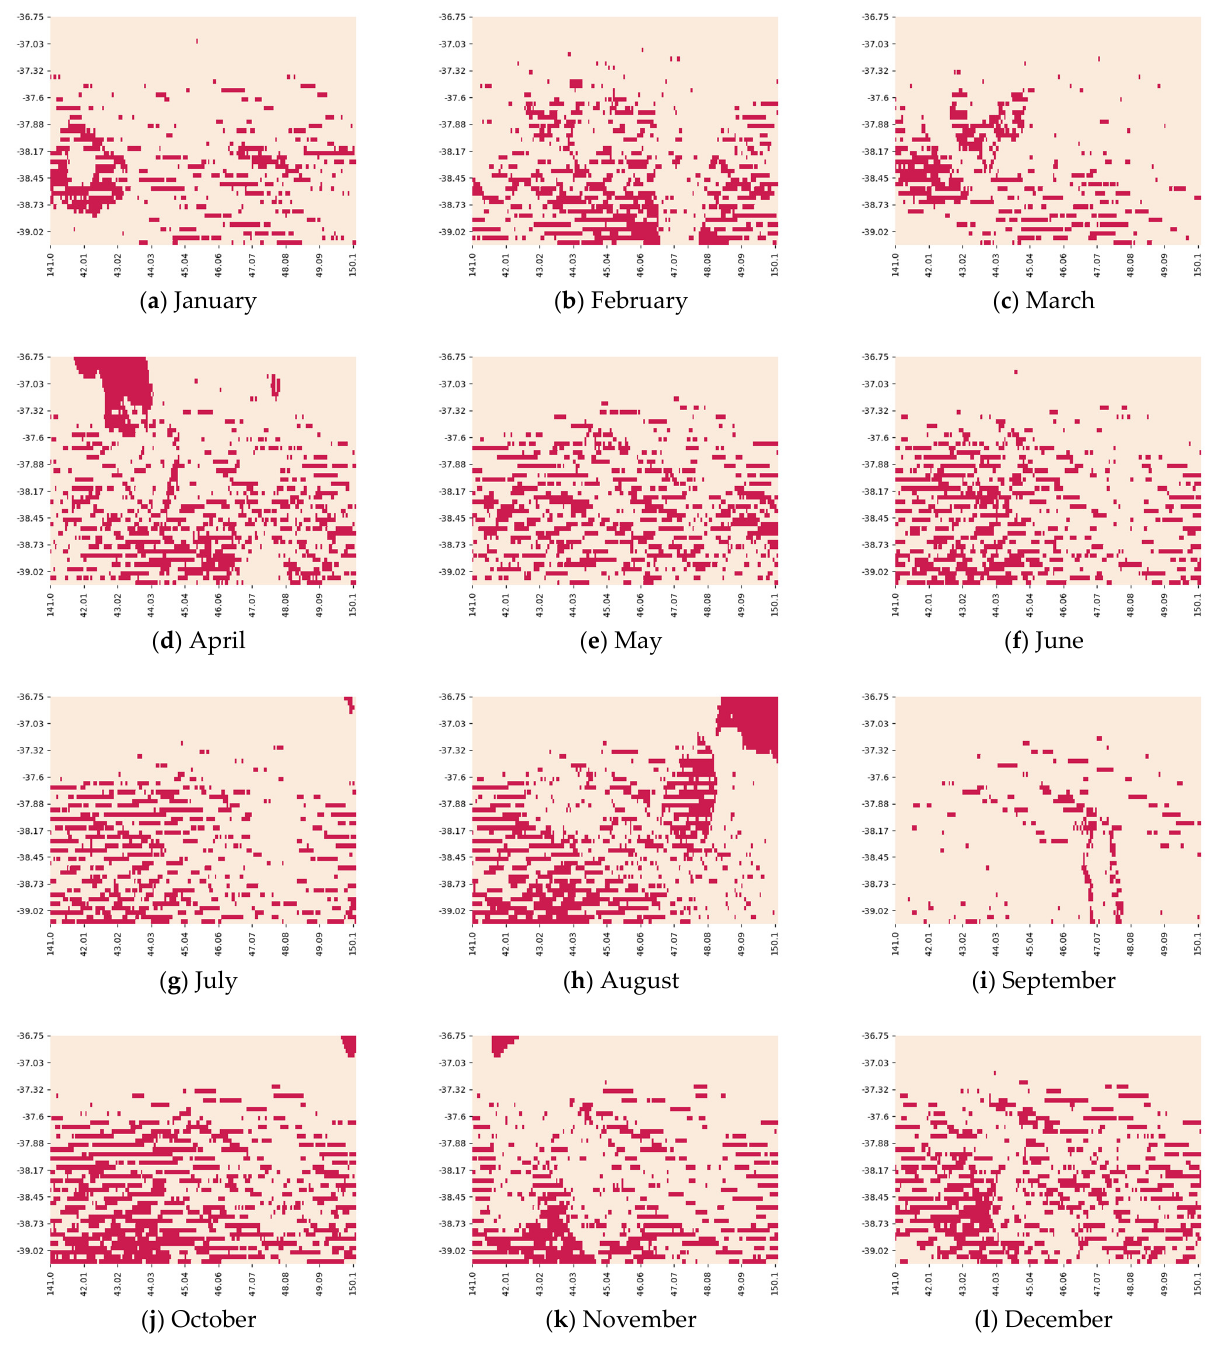
Figure A1. Heatmaps of the geolocated grids for Temperate Region of Australia in 2016 for 12 months. Cream colour denotes the grids which are not classified correctly. Red colour indicates the grids which are classified correctly. Figures ( a – l ) represent the heat map for 12 different months,